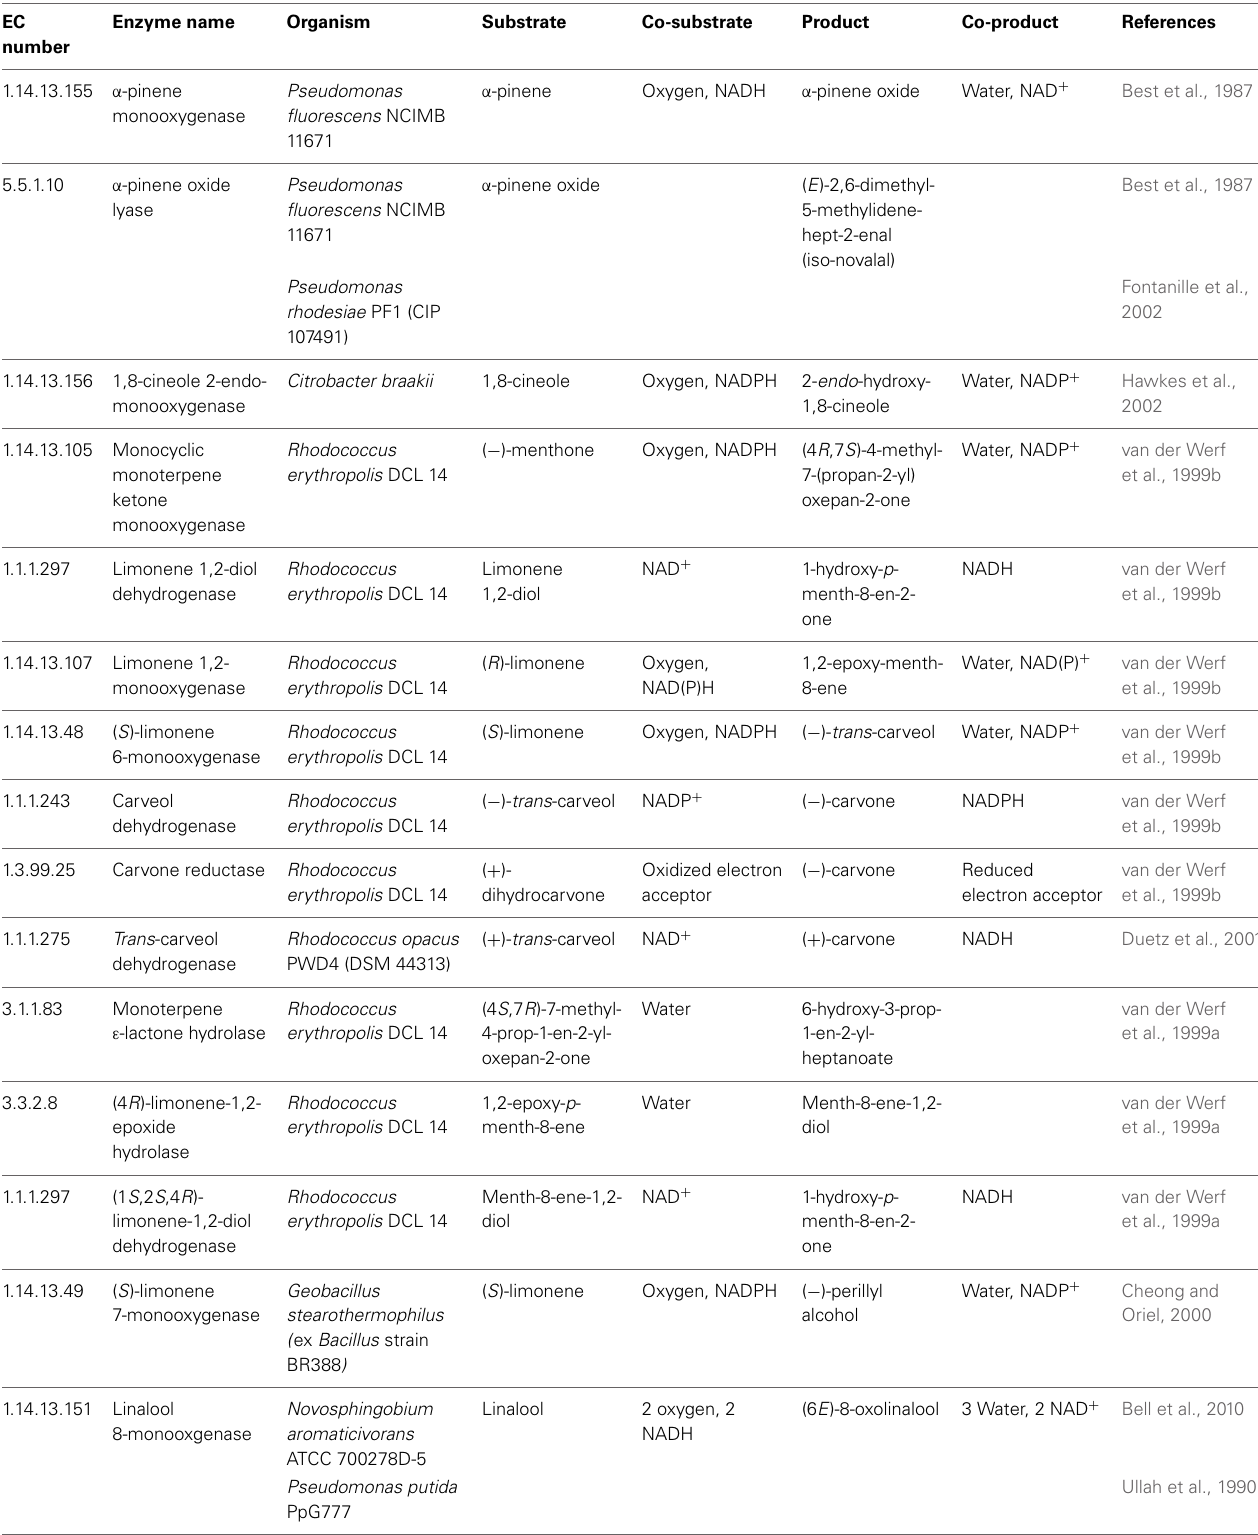
Table 1 | Summary table of monoterpene transforming enzymes in validly described species of Bacteria